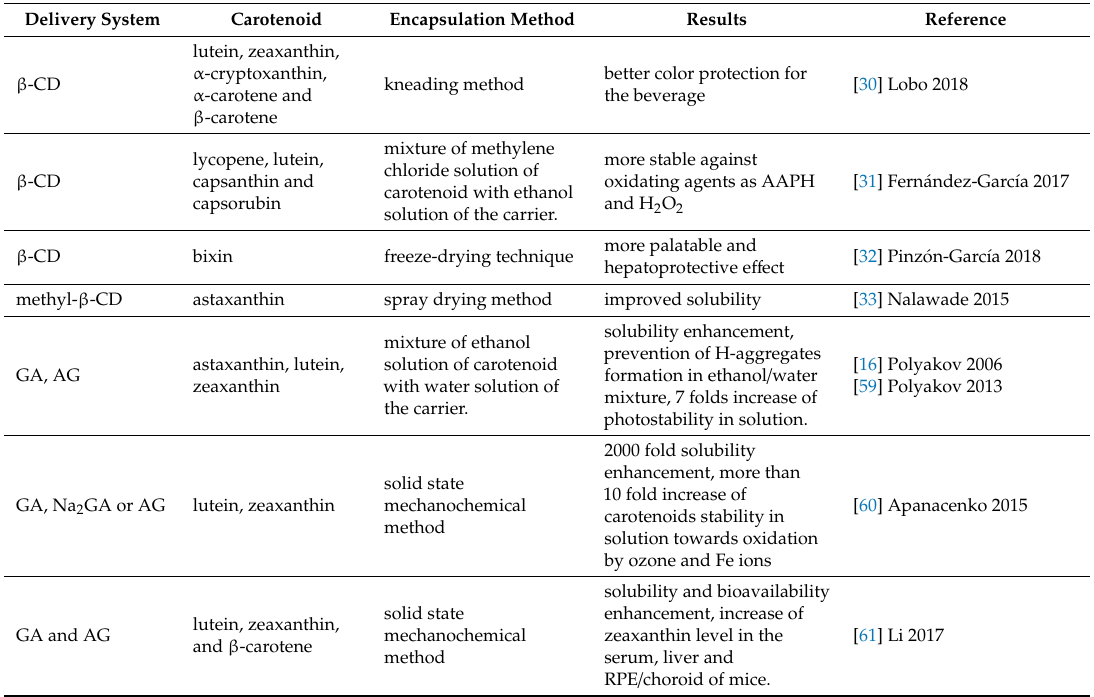
Table 2. Inclusion complexes of cyclodextrin (CD), glycyrrhizic acid (GA) and arabinogalactan (AG) as delivery systems for carotenoid